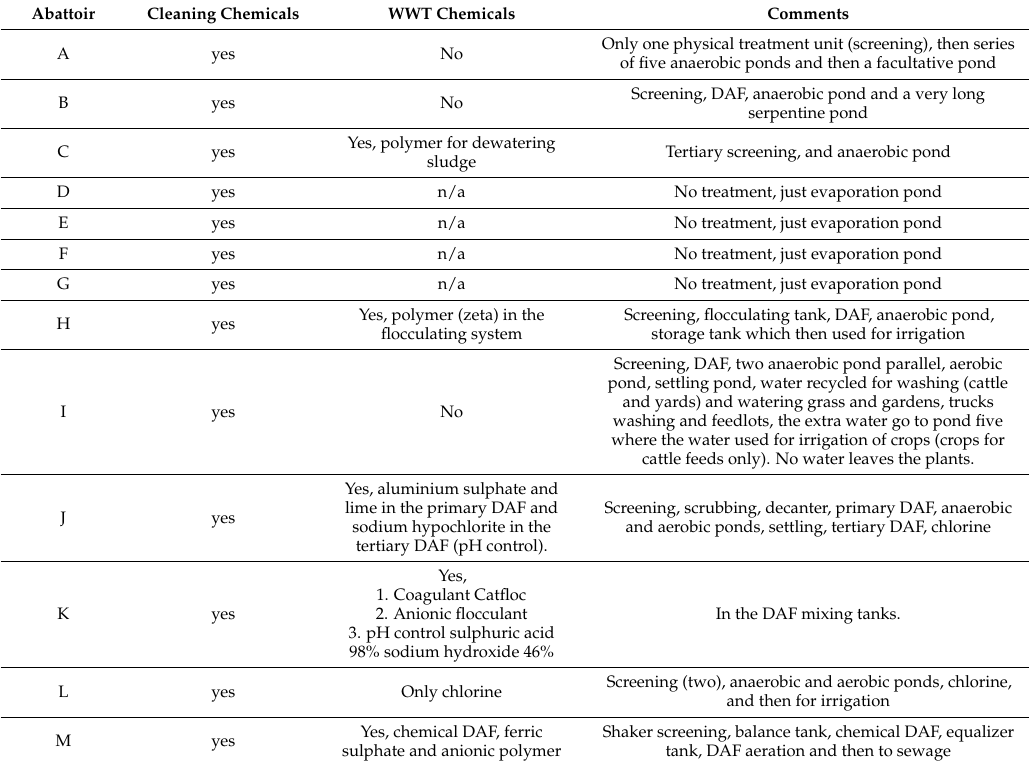
Table 12. List of many abattoirs in Australia and their usage of chemicals [73] (data collected by the author).